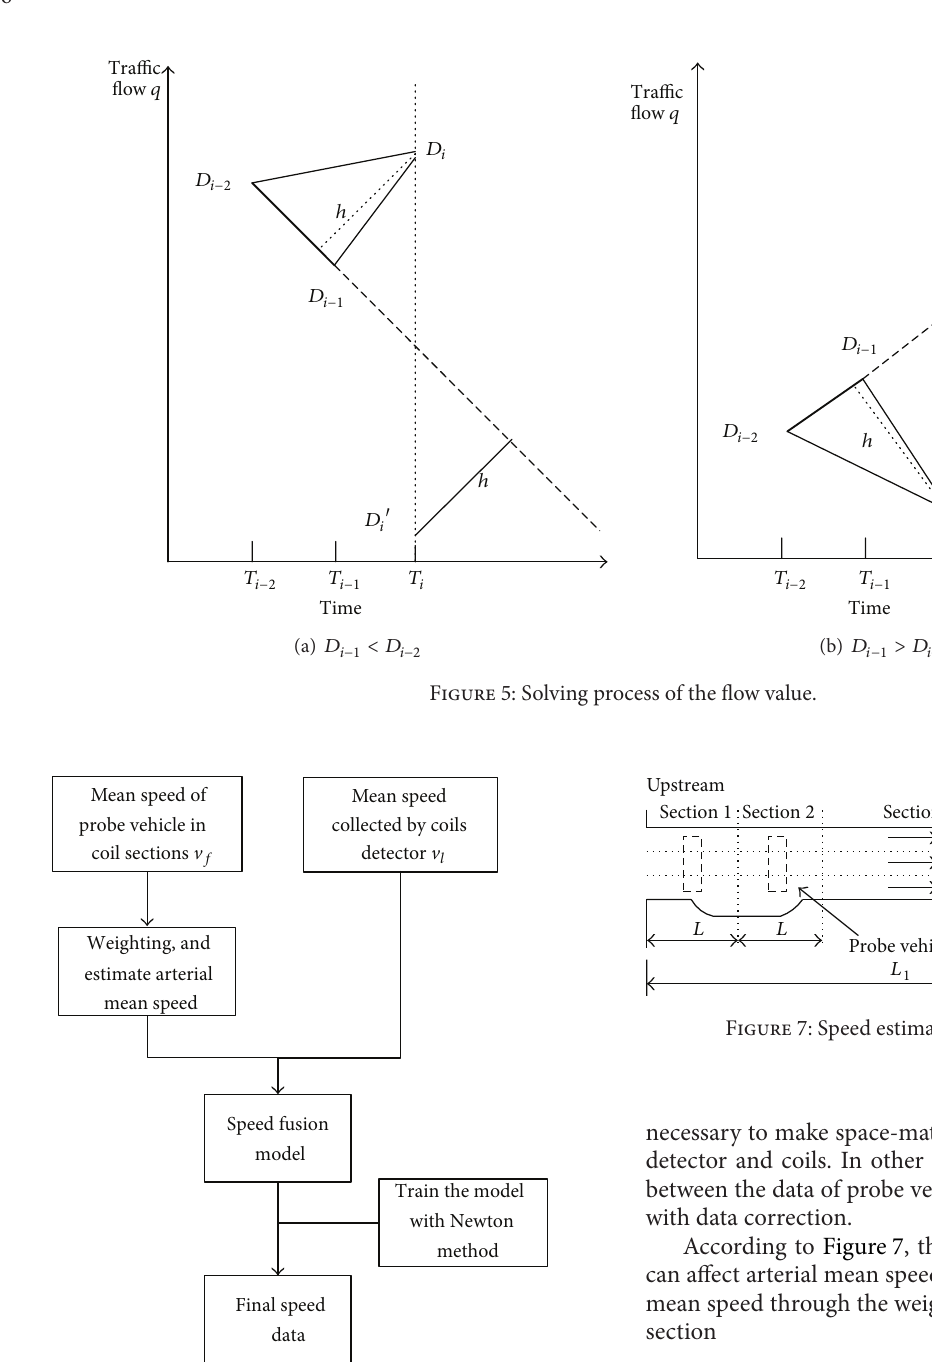
Figure 6: Flow chart of speed fusion and estimation based on space matching.